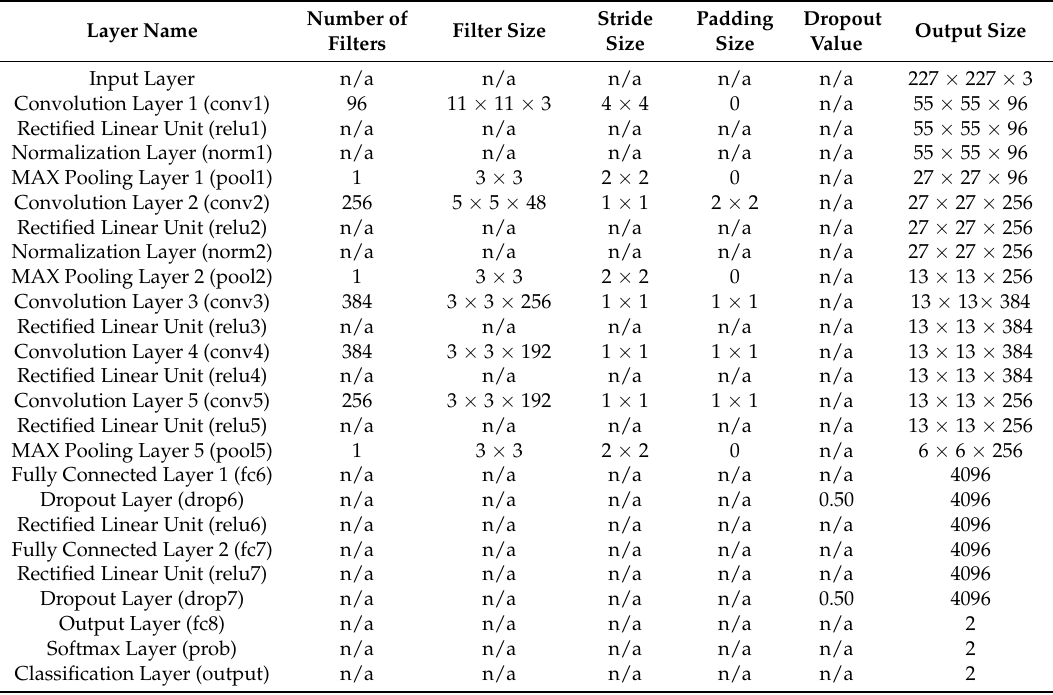
Table 2. Description of CNN structure based on Alex network for PAD